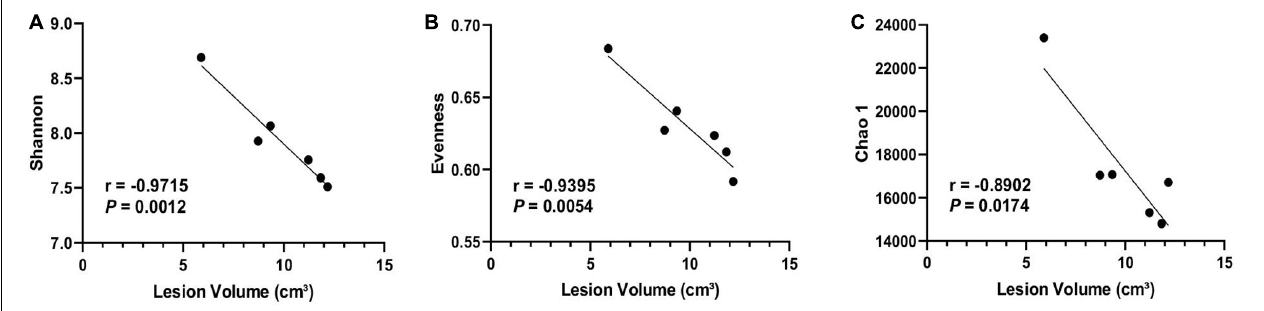
FIGURE 3 | Microbial diversity was negatively correlated with brain lesion volume. Brain lesion volume measured 1 day poststroke was negatively correlated with alpha-diversity indices including (A) Shannon, (B) Evenness, and (C) Chao1 at 3 days poststroke ( n = 6). Regression analysis was performed to evaluate associations between microbial composition and stroke severity. Pearson correlation coefficient and P- values are shown.